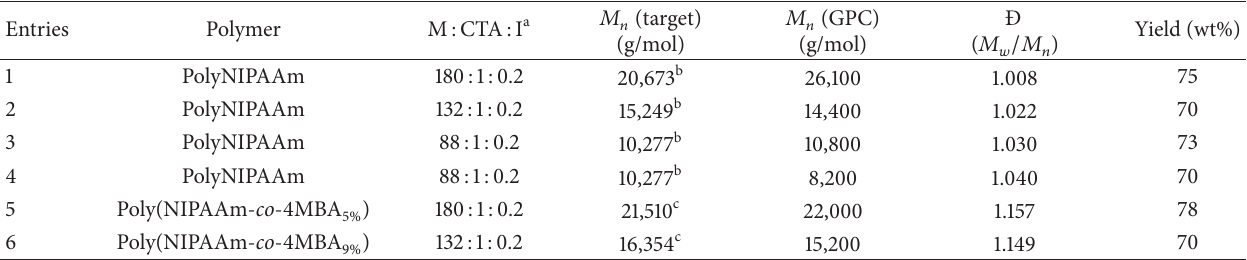
Table 1: Preparation of linear macro-CTAs at 70 ∘ C in p -dioxane for